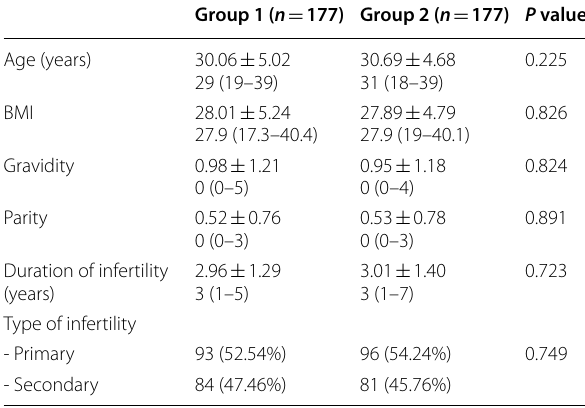
Table 1 The demographic characteristics of the two groups